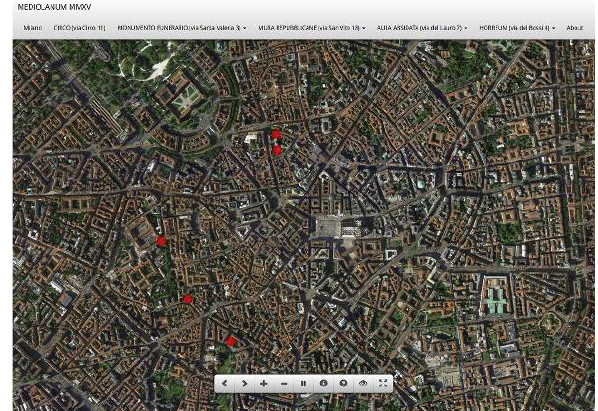
Figure 4. The graphical interface for virtual visits through navigable panoramic photos on the “Milano Archeologia” web